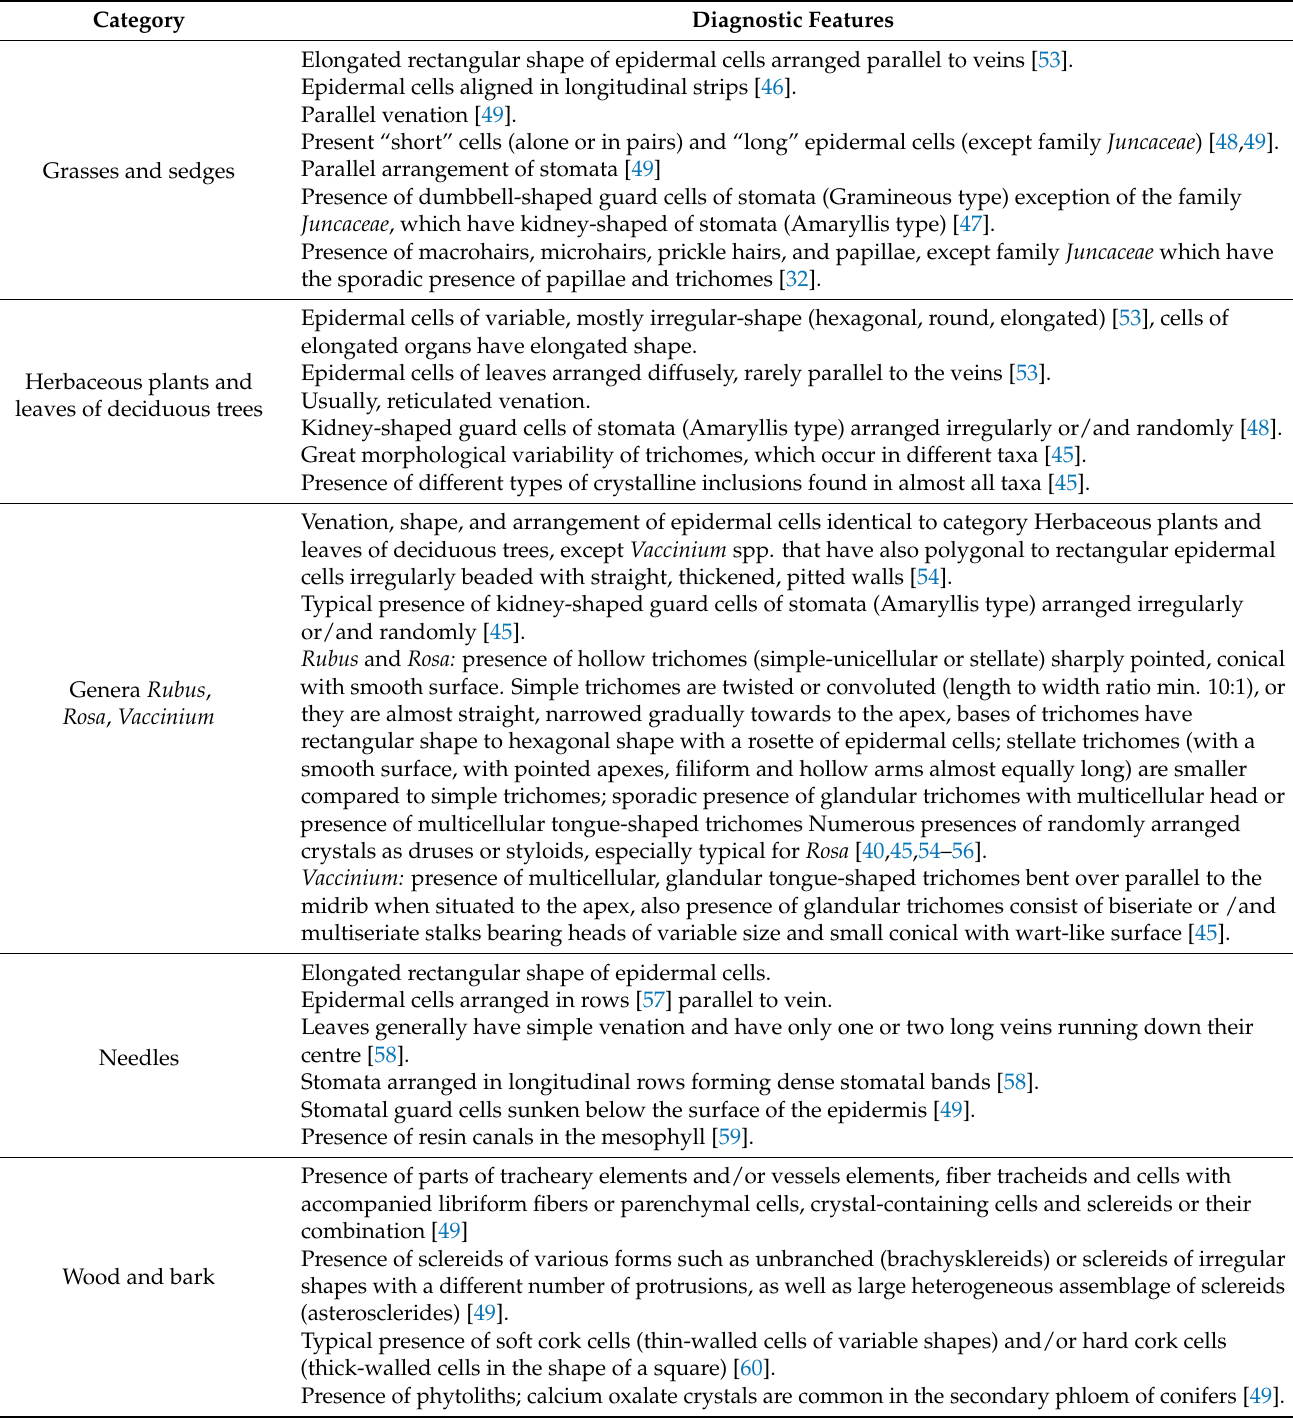
Table 1. List of seven functional groups based on similar anatomical features as arrangement, type and size of basic plant microstructures consistent with classifications used in the majority of studies on ungulate diet with a description of detailed diagnostic features for each botanical